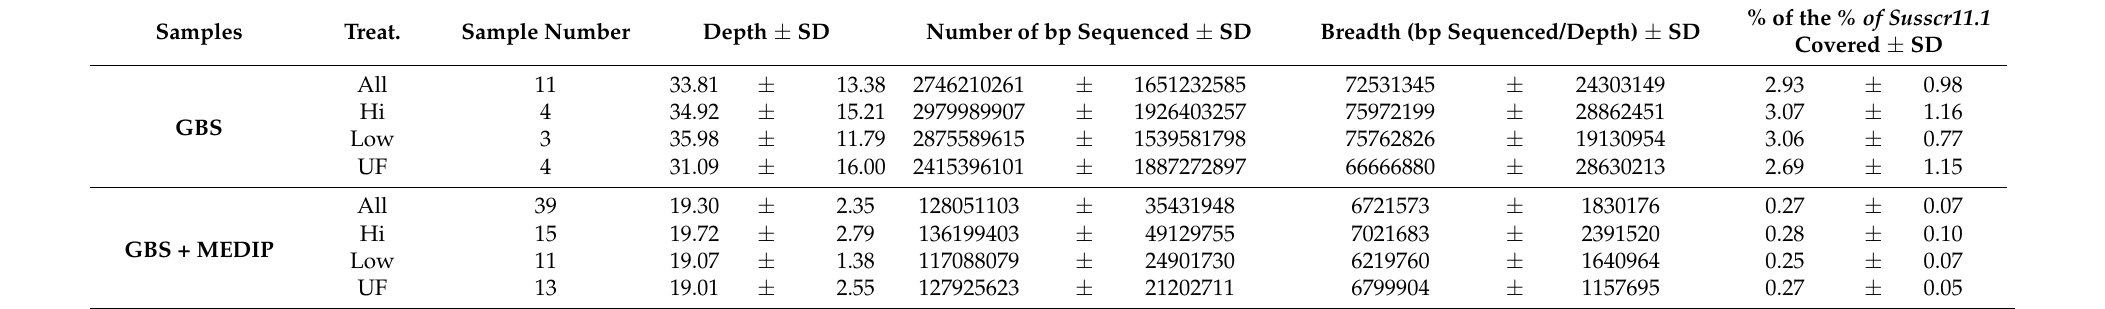
Table 5. Average sequencing and alignment statistics for individual